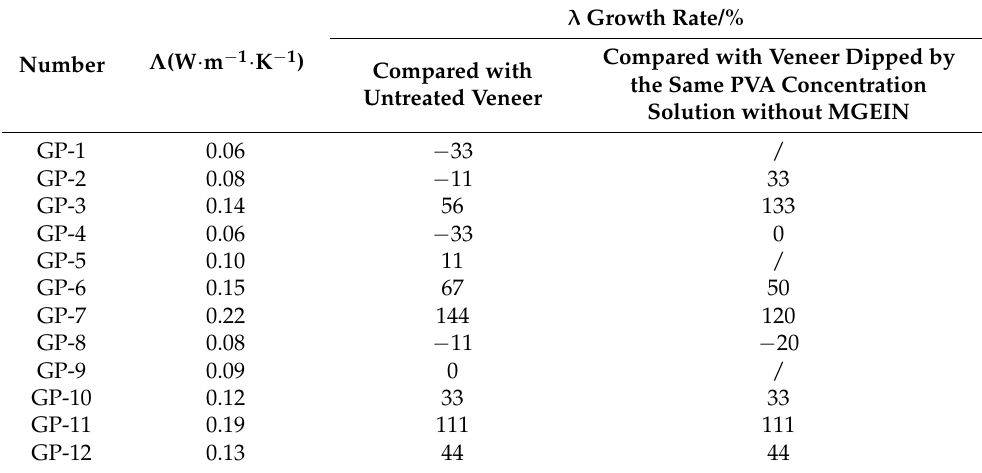
Table 2. Thermal conductivity of Gr/PVA impregnated modified